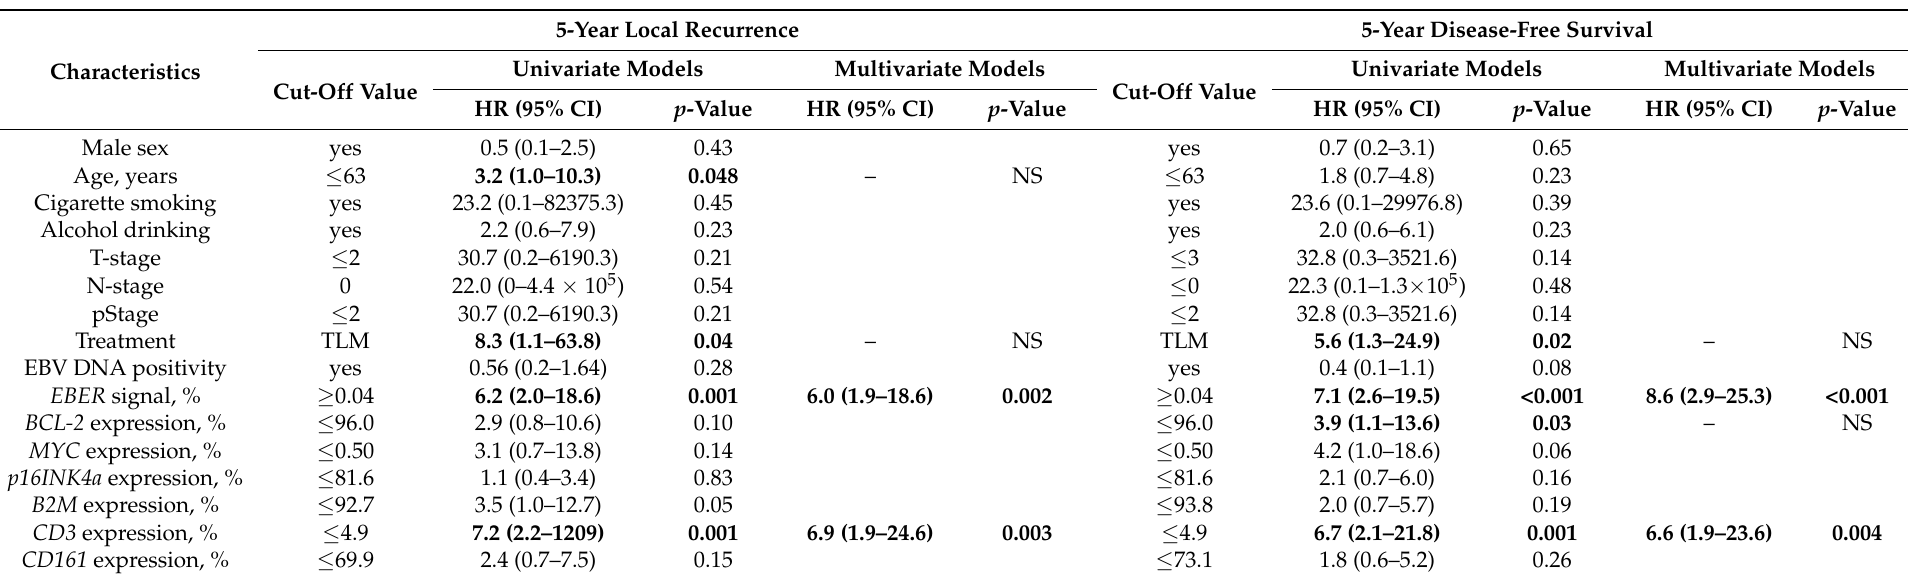
Table 5. Cox regression models of variables of interest for predicting five-year prognosis in patients with